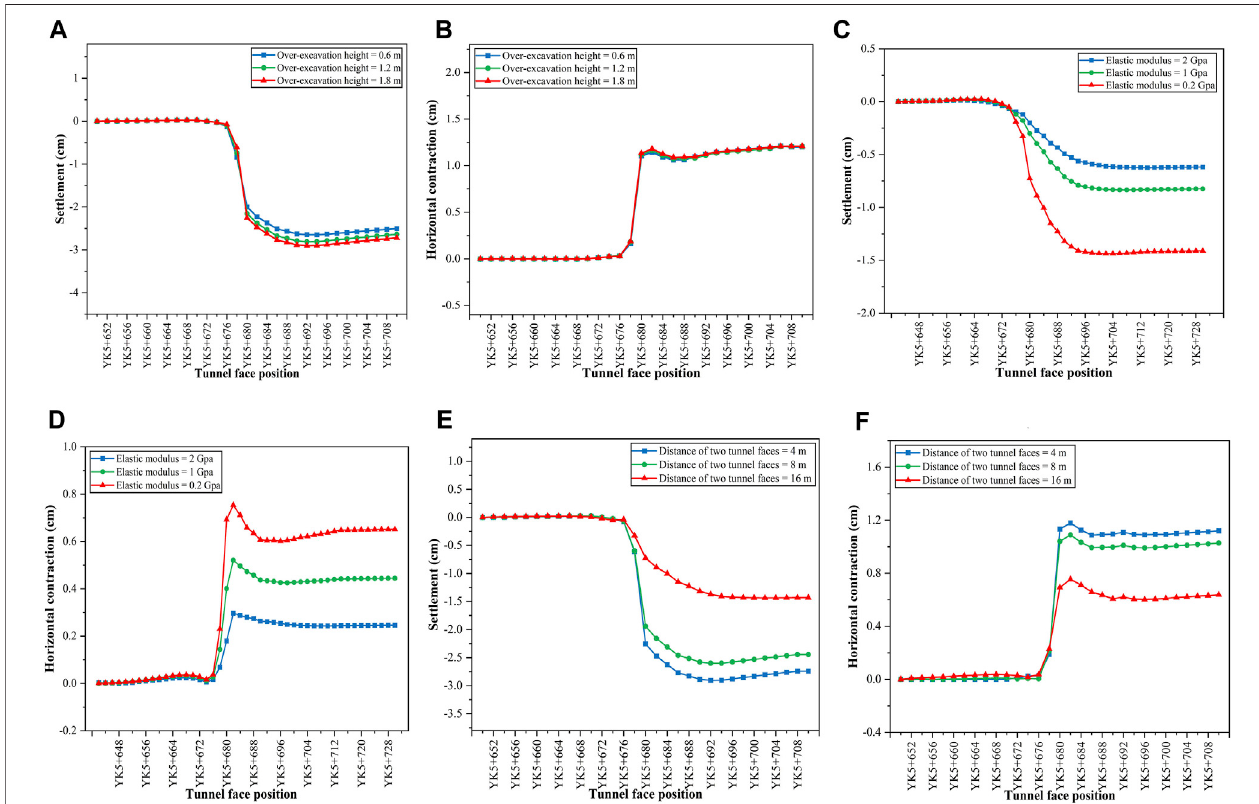
FIGURE 9 | Tunnel deformation at YK5+680 under different variables. (A) Crown settlement for three over-excavation heights and (B) Horizontal contraction at YK5+680forthreeover-excavationheights. (C) Crownsettlementforthreesurroundingrockstrengthand (D) horizontalcontractionforthreesurroundingrockstrength. (E) Crown settlement for three distances between two tunnel faces and (F) horizontal contraction for three distances between two tunnel faces.